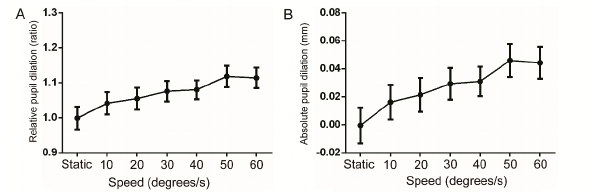
Figure. 2 The relative pupil diameter with static optotypes and moving optotypes at the speeds of 10, 20, 30, 40, 50, and 60 degrees/s (n=28). A. The relative ratio of pupil diameters; B. Absolute value of the pupil diameter change. Table 1. Pupil diameter and pupil dilation of all speeds.